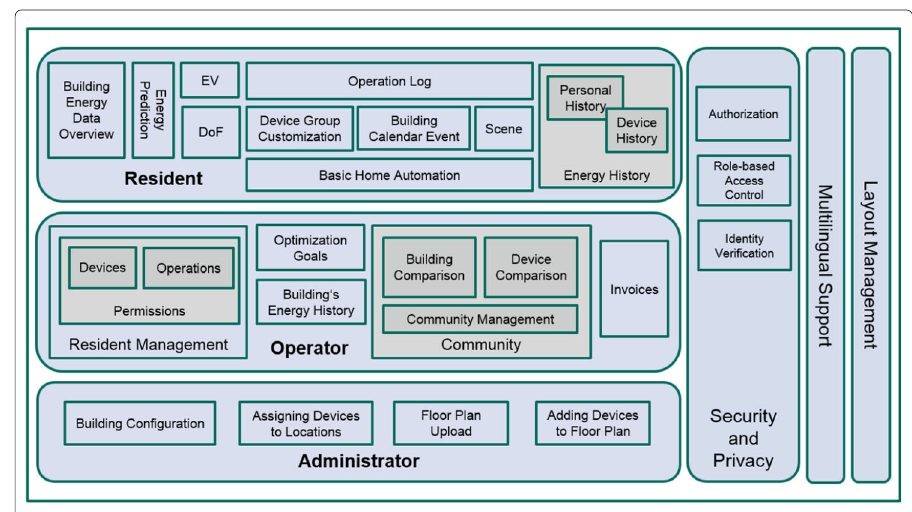
Fig. 9 The functional components of the generic user interface for building operating